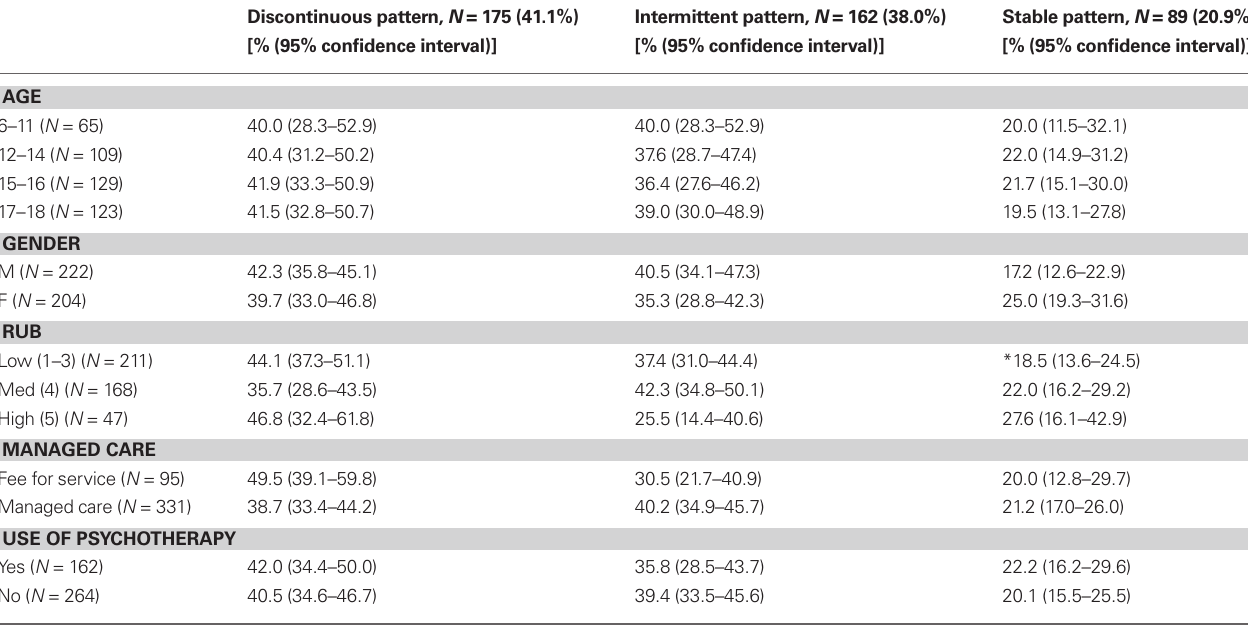
Table 1 | Stability of bipolar diagnosis by demographic and clinical characteristics ( n = 426). Discontinuous pattern, n = 175 (41.1%)